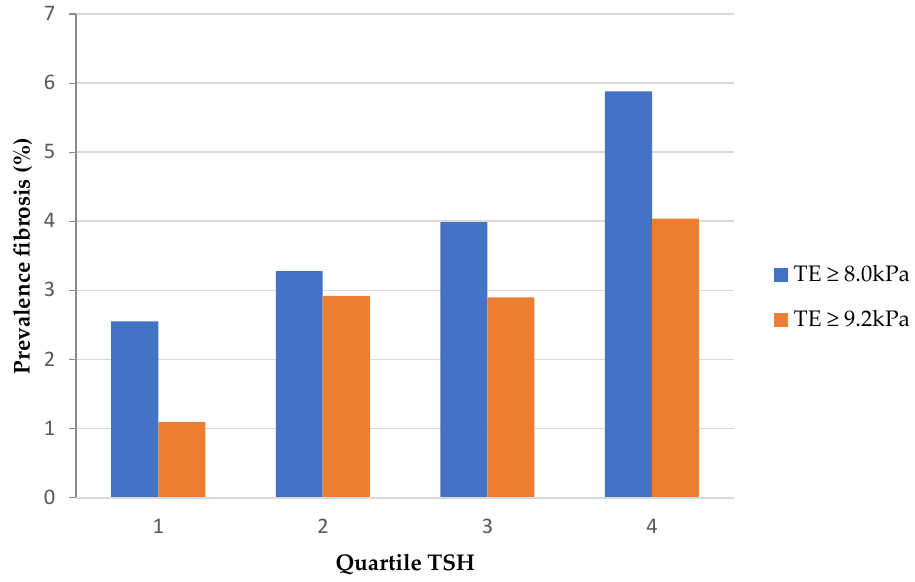
Figure 1. Prevalence of liver fibrosis according to TSH quartiles. Abbr: TE, transient elastography; TSH, thyroid stimulating hormone.